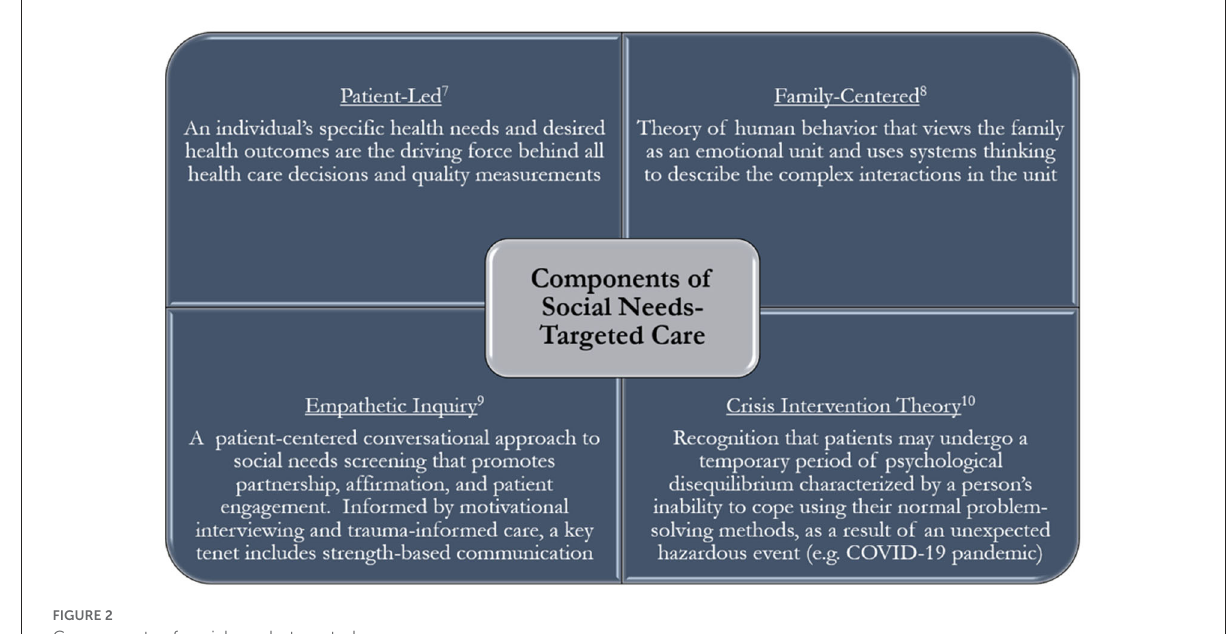
FIGURE2 Components of social needs-targeted